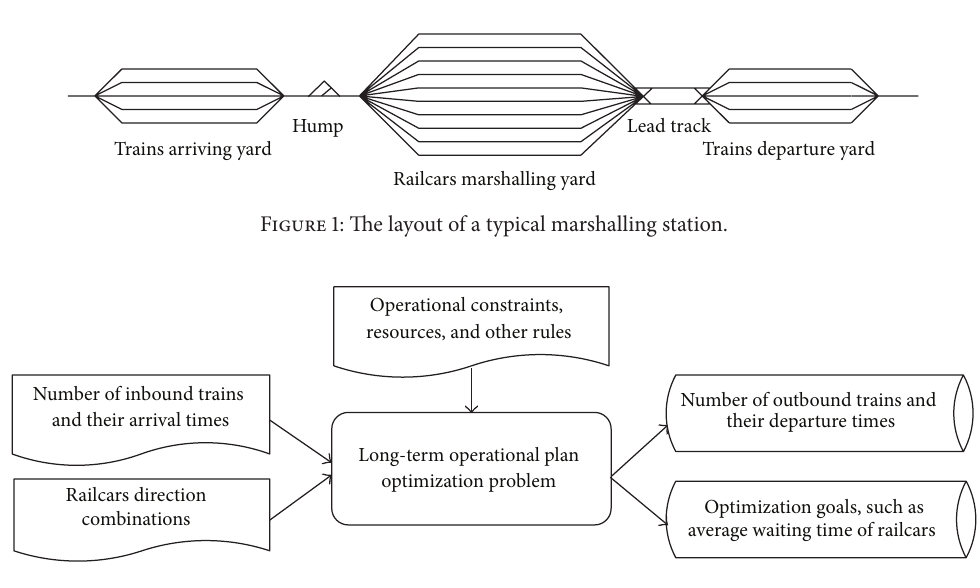
Figure 2: Long-term operating plan optimization